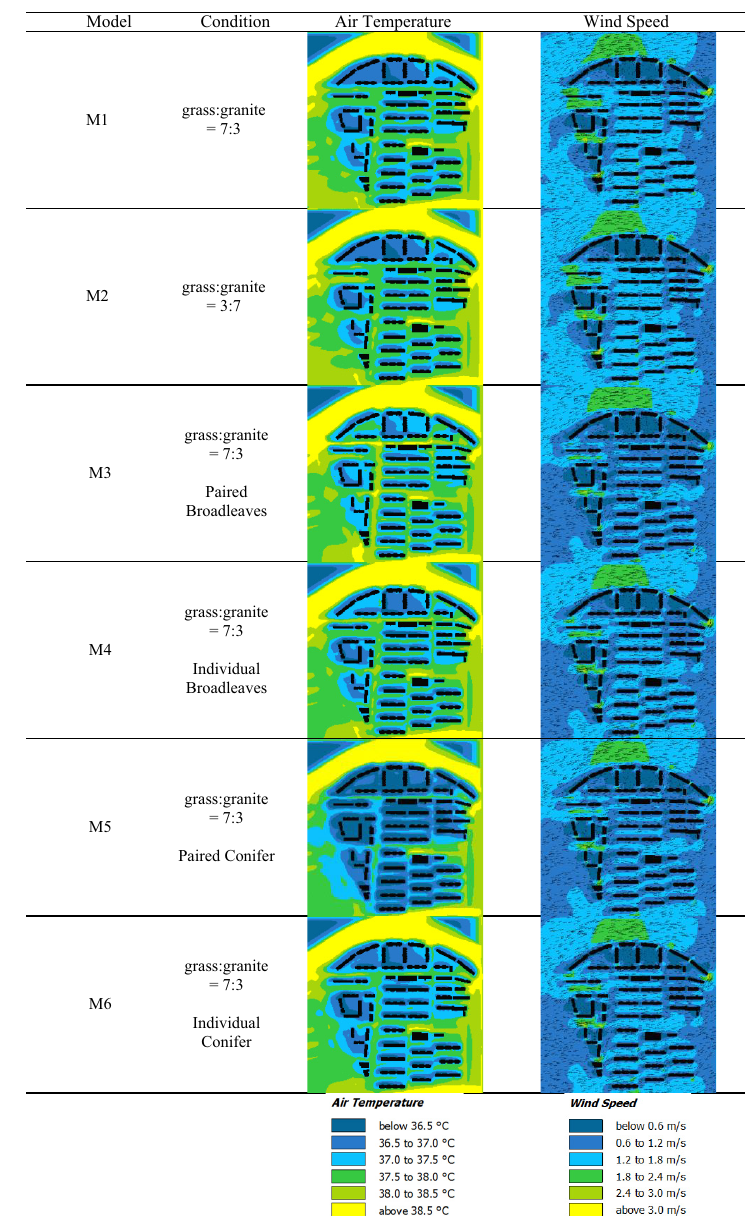
Figure 7. Simulation results of air temperature and wind speed under extreme heat